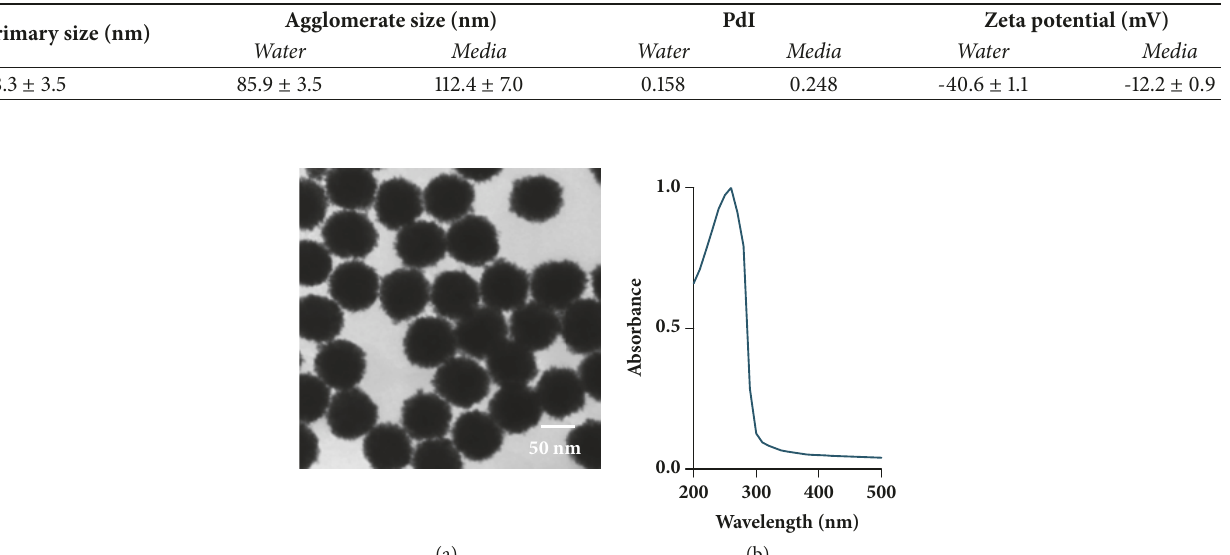
Table 1: PtNP characterization assessments.